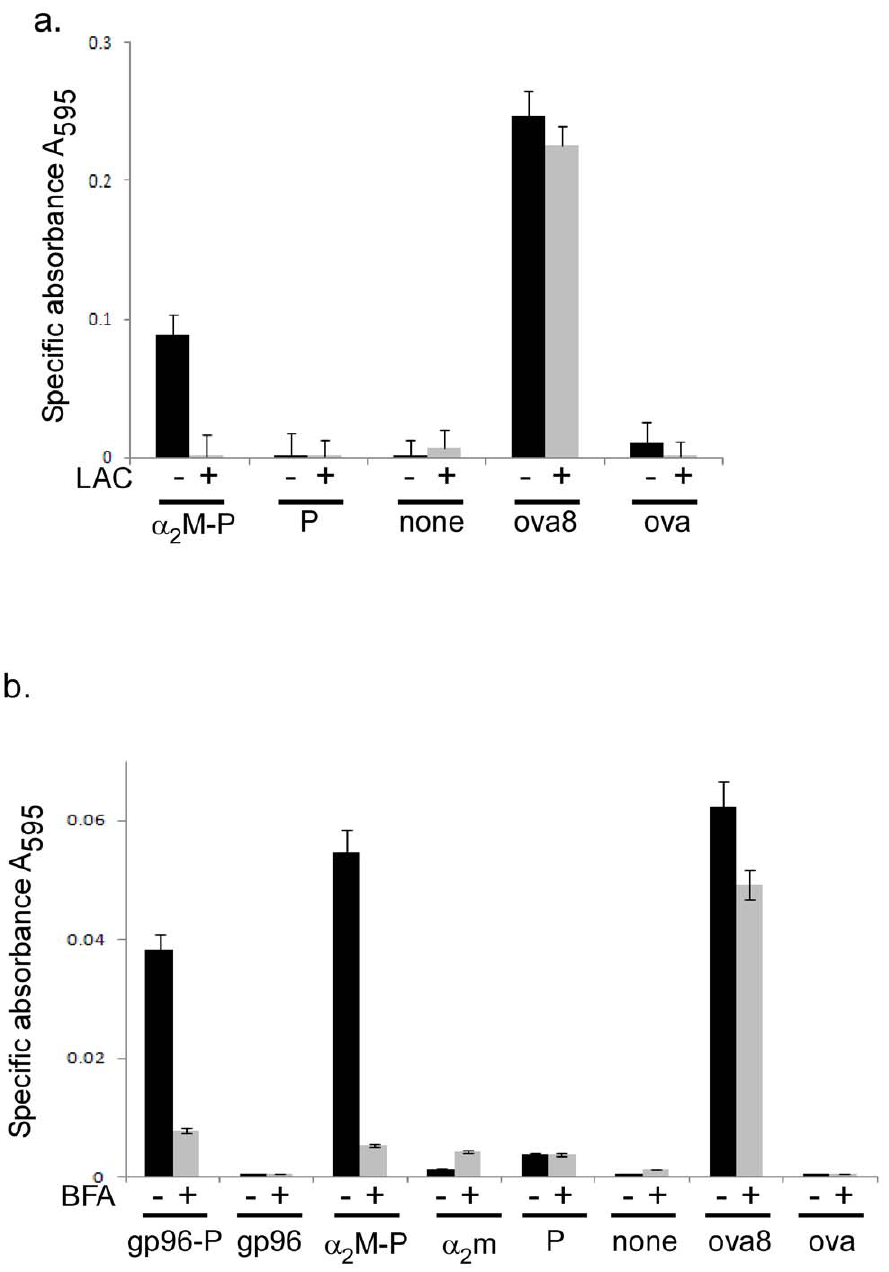
Figure 4. Cross-presentation of a 2 M-chaperoned peptides is dependent on proteasomes and vesicular trafficking. a) a 2 M complexed to the ova 19-mer peptide (P) was incubated with bone marrow-derived dendritic cells in the presence or absence of the proteasome inhibitor lactacystin. Controls include cells incubated with peptide alone, ova8 or ovalbumin protein (ova) or PBS (none). B3Z activation was monitored at A 595 after addition of substrate. b) a 2 M or gp96 complexed to the ova 19-mer peptide (P) were incubated with bone marrow-derived dendritic cells in the presence or absence of BFA. Controls include cells incubated with ova 19-mer peptide alone (P), ova8 or ovalbumin protein (ova) or PBS (none). B3Z activation was monitored at A 595 after addition of substrate. Error bars in (a,b) represent standard deviation of